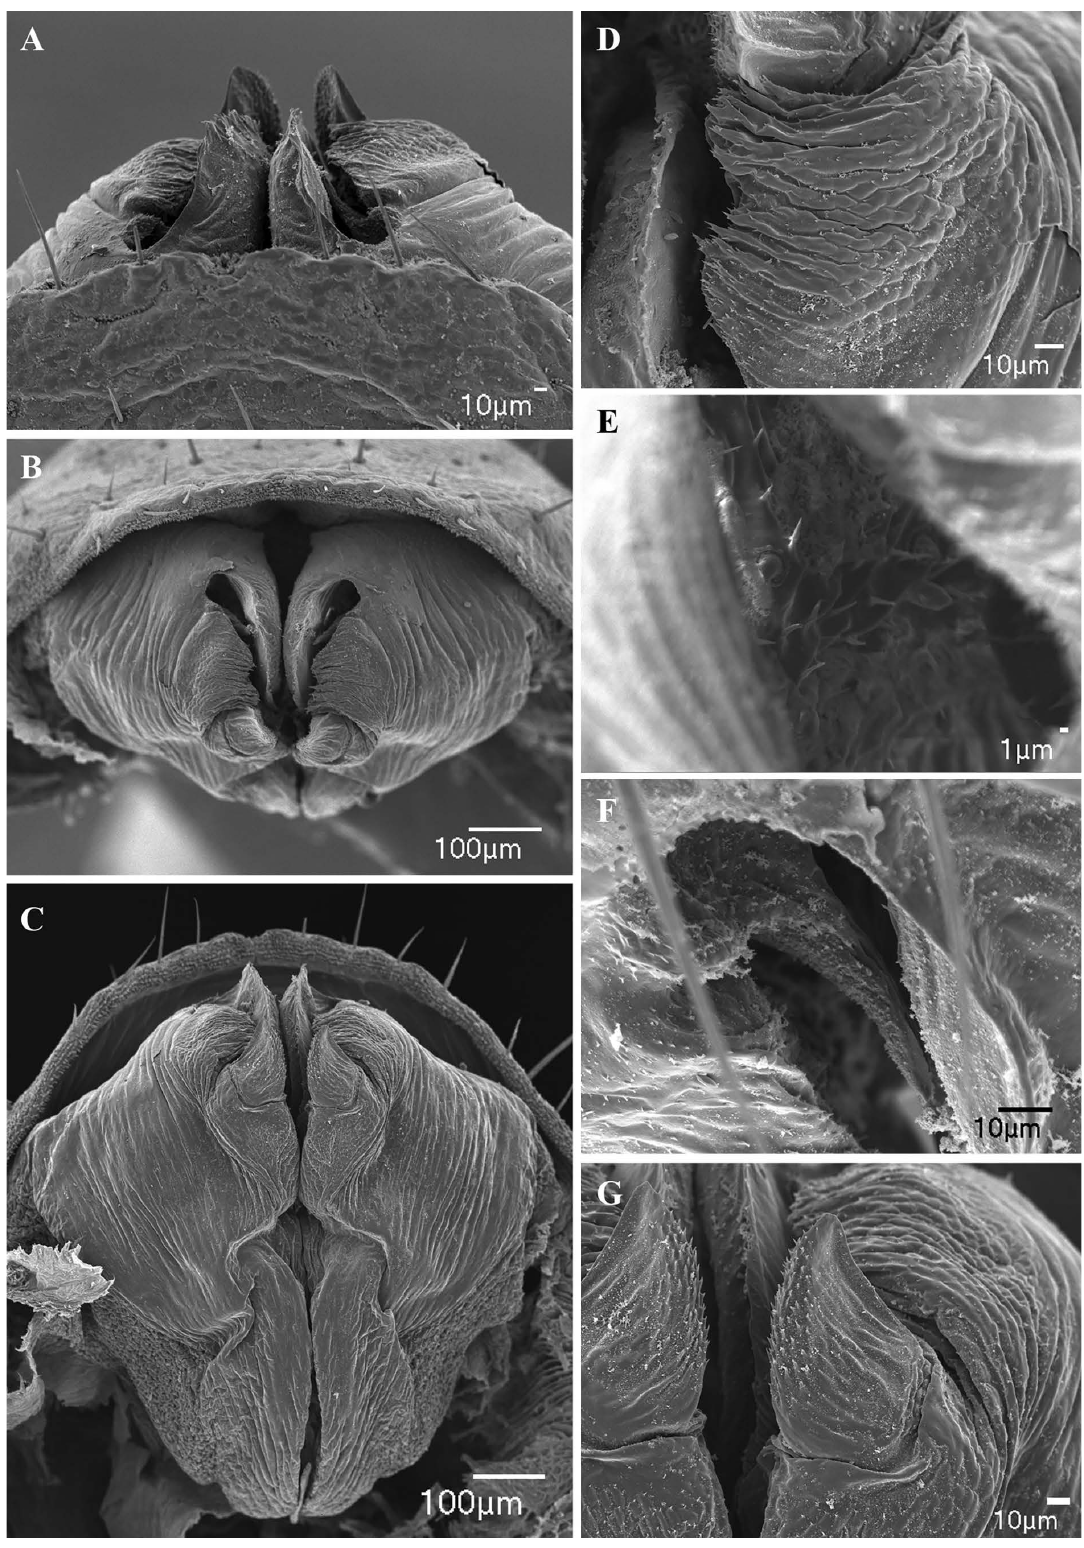
Fig. 114. Sarax indochinensis sp. nov. (ZMUC 21612), male gonopod. A . Ventral view. B . Posterior view. C . Dorsal view. D . Detail of lateral lobe 2. E . Detail of spiny inner region of fistula. F . Processus internus. G . Detail of apex of dorsal